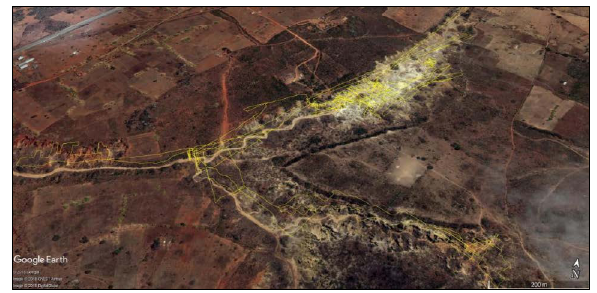
Satellite image indicating flight paths of the uncrewed aerial vehicle in yellow.